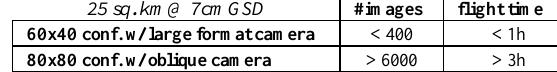
Table 1: Typical nadir-based (up) and oblique (down) flight